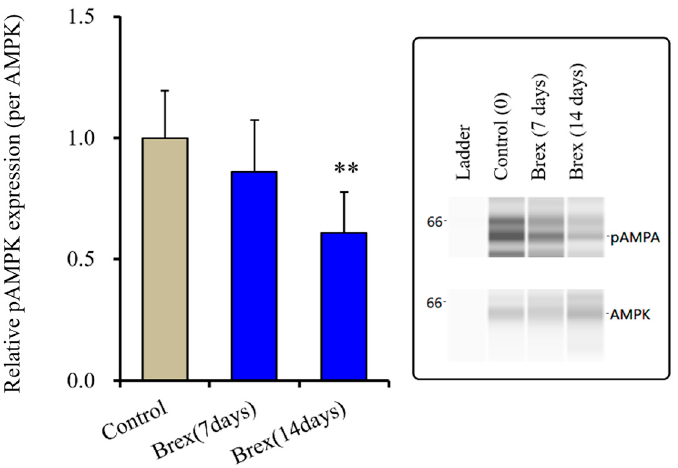
Figure 3. Effects of subchronic administration (7 and 14 days) of therapeutic relevant concentration of Brex (Brex: 300 nM) on protein expression of phosphorylated protein kinase B (pAkt) (panel A ) and phosphorylated extracellular signal-regulated kinase pErk (panel B ) in the plasma membrane fraction of cortical primary cultured astrocytes. In left side histograms, ordinate: mean ± SD ( n = 6) of the relative protein level of pAkt and pErk per GAPDH. * p < 0.05: relative to control (Brex-free) by one-way ANOVA with Tukey’s post-hoc test. Right side panels indicate their pseudo-gel images using capillary immunoblotting.